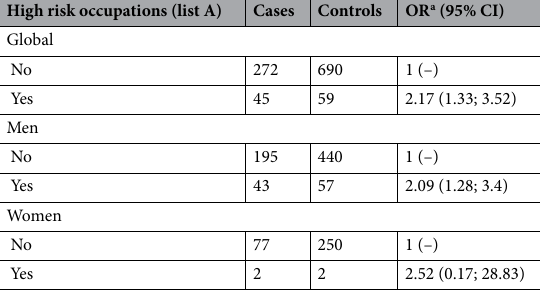
High risk occupations (list